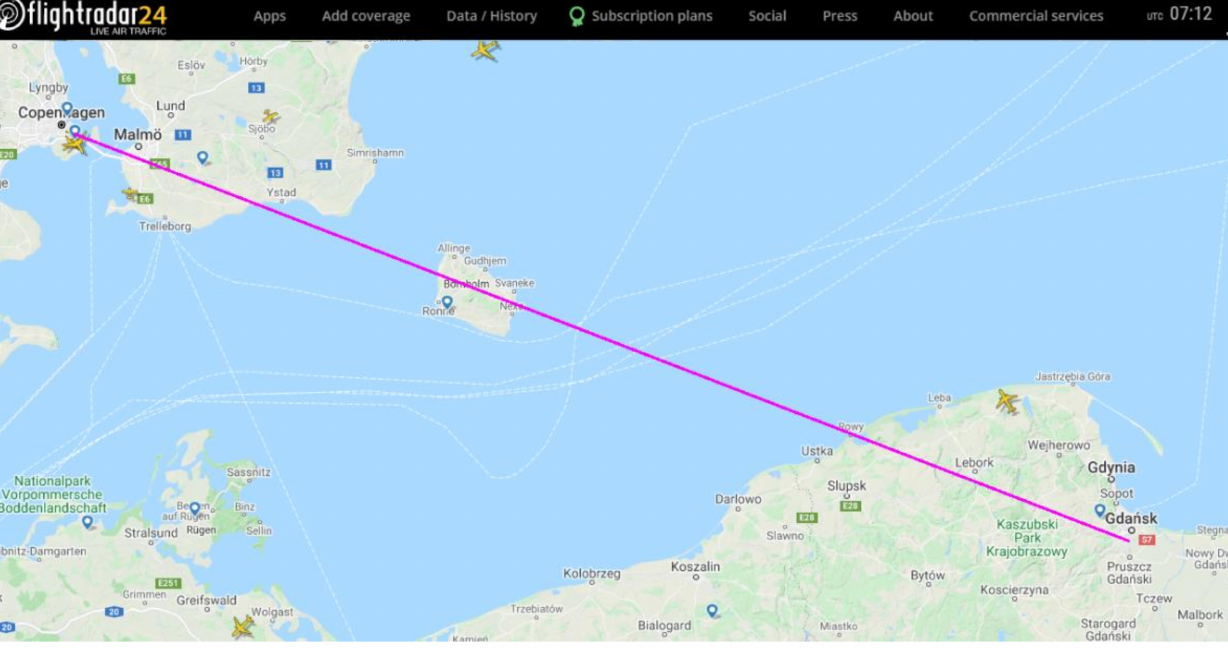
Figure 2. Visualization of the flight trajectory between Copenhagen and Gdansk airports (retrieved from [29]). The main parameters of the exemplary flight carried out by Boeing 737-300 are shown in Figure 3.